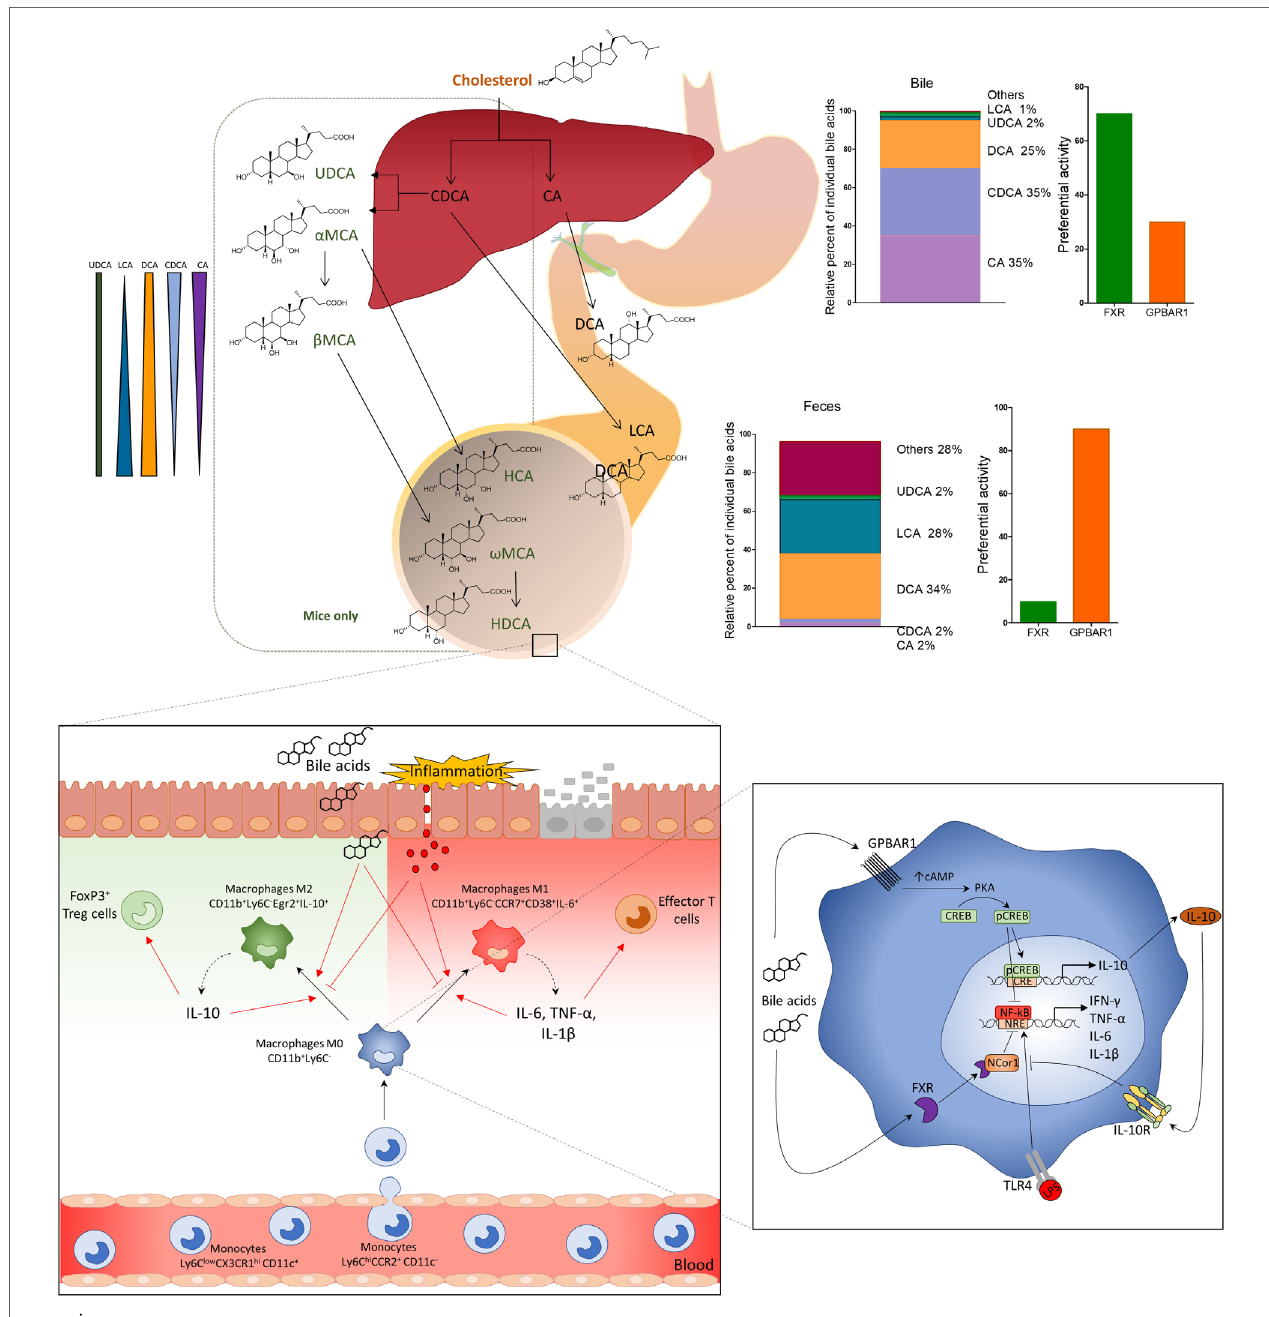
FiGuRe 2 | Primary bile acids (cholic acid and chenodeoxycholic acid), conjugated with glycine or taurine, are secreted in the small intestine and subjected to deamidation by intestinal microbiota and to 7-dihydroxylation to secondary (or degenerated) bile acids deoxycholic acid and lithocholic acid. In the distal ileum and colon, primary and secondary bile acids regulate leukocyte trafficking and macrophages differentiation via activation of G-protein bile acid receptor 1 (GPBAR1) and Farnesoid-X-Receptor (FXR). After breach of the epithelial barrier, or pathogenic invasion, molecules like LPS activate macrophages by TLR, thus inducing the production of pro-inflammatory cytokines, IFN- γ , TNF- α , IL-6, and IL-1 β , which polarize M0 macrophages CD11b + Ly6C − toward a pro-inflammatory M1 phenotype, CD11b + Ly6C − CD38 + IL-6 + . M1 macrophages might induce production of effector T cells and up-regulation of the expression of chemokine CCL2 in the colon, which attract more monocytes Ly6C hi CCR2 + from the blood to the lamina propria . Activation of GPBAR1 and FXR reverses this inflammatory pathway, shifts the macrophage polarization toward an anti-inflammatory phenotype M2 CD11b + Ly6C − Egr2 + IL-10 + , which produces high concentrations of IL-10. IL-10, in its turn, increases the production of Treg cells FoxP3 + and reduces the expression of CCL2 recruiting fewer monocytes from the blood to the lamina propria of colon. GPBAR1 signaling involves cAMP-protein kinase A (PKA)-mediated inhibition of NF- κ B, and FXR signaling leads to FXR-nuclear receptor corepressor 1-mediated repression of NF- κ B-responsive elements. Bile acid stimulation of both pathways blunt NF- κ B-dependent gene expression. In addition, GPBAR1 directly regulate the IL-10 expression by a cAMP/PKA/p cAMP-responsive element-binding protein pathway.